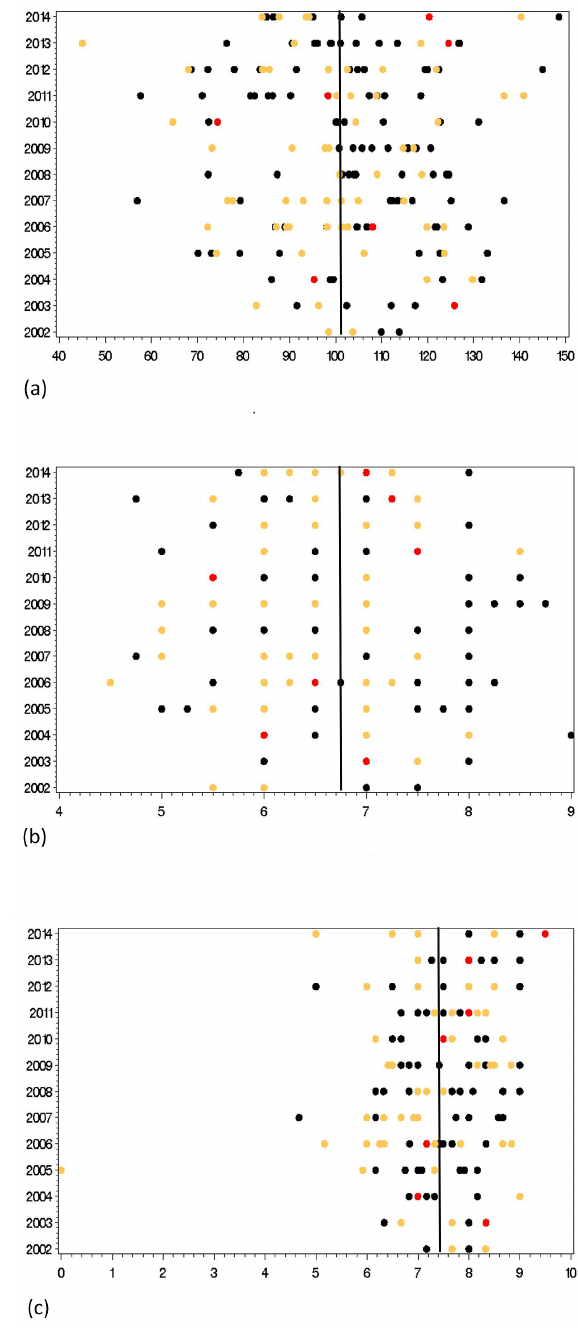
Figure 1. Individual scores from the performance test of 169 Noriker stallions in the testing years 2002 to 2014 for (a) the fi- nal performance score, (b) driving ability, and (c) willingness to work in heavy-load lodging. Non-carrier stallions of the glycogen synthase 1 mutation (R / R) are marked by black dots, heterozy- gous animals (R / H) are marked by orange dots, and homozygous animals (H / H) are marked by red dots. The overall mean score is indicated by a vertical line in each of the